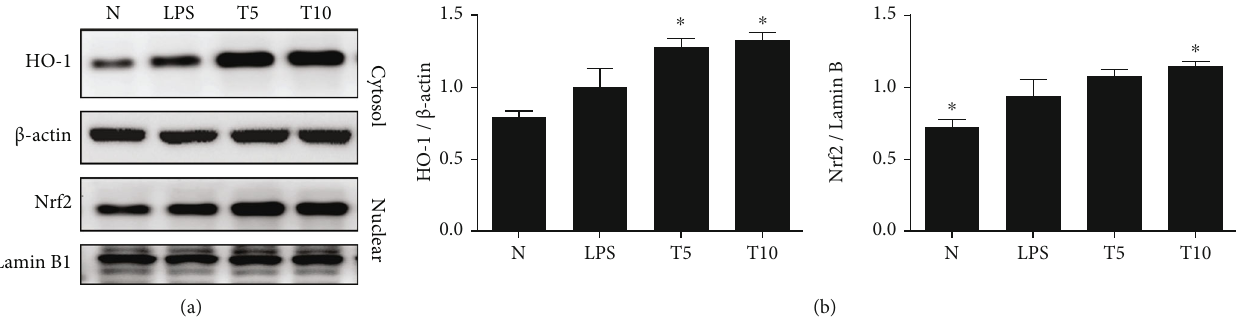
Figure 6: Tomatidine regulated HO-1 expression in the lung of mice. (a) Tomatidine increased HO-1 and Nrf2 protein expression. (b) The fold change in the expression of HO-1 and Nrf2 protein was measured relative to the expression of β -actin and lamin B, respectively. Data are presented as the mean ± SEM . ∗ p < 0 : 05 vs. LPS group. N group: normal control mice; LPS group: LPS treatment only; T5 group: 5mg/kg tomatidine plus LPS; T10 group: 10 mg/kg tomatidine plus LPS.